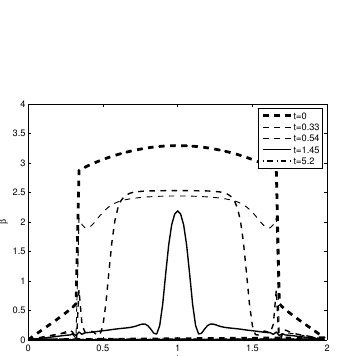
Figure 16. The dependence of β ( l,t i ) with with the Lattes and Lions regularization on l for ωτ = 0 ⇒ 8, (cid:15) = 4 × 10 − 4 .